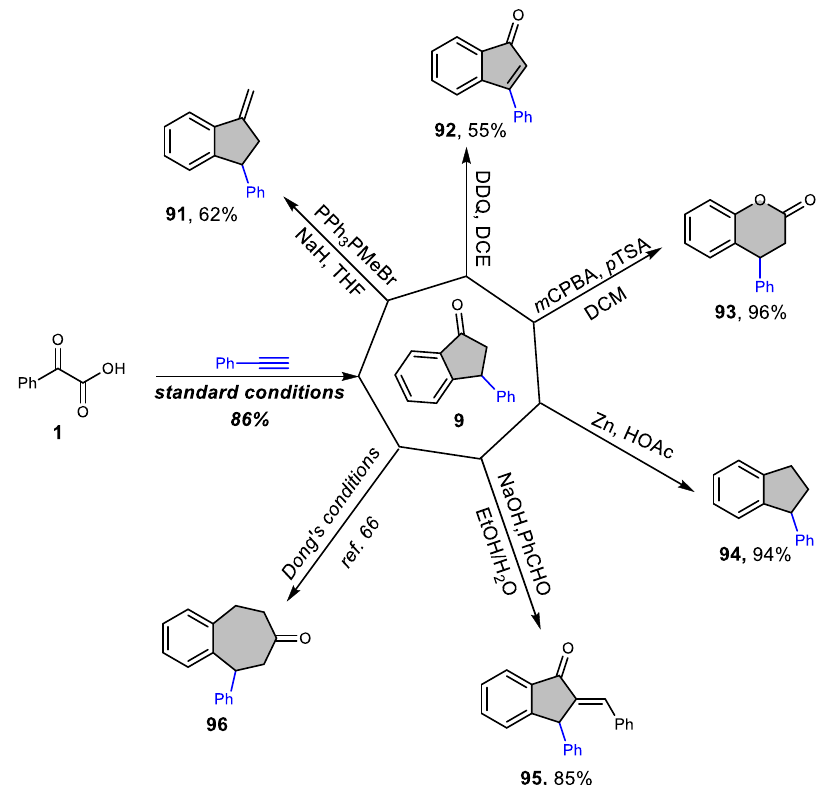
Fig. 6 Further transformations of indanones. The indanone 9 was prepared from 1 under standard conditions. The indanone 9 was ef fi ciently transformed to diverse compounds, such as alkene 91 , indenone 92 , lactone 93 , 1-phenyl-2,3-dihydro-1 H -indene 94 , ( E )-2-benzylidene-3-phenyl-2,3-dihydro-1 H -inden- 1-one 95 , and benzocycloheptenone 96 , respectively.